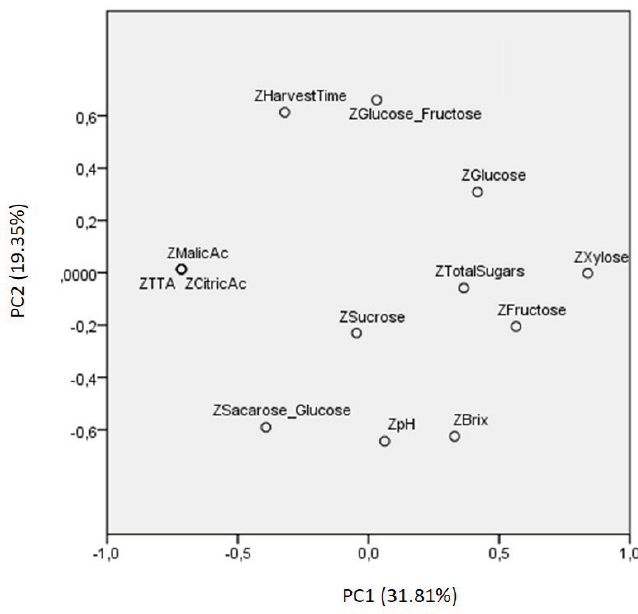
Fig. 2: Principal component analysis (PCA) of agronomical and biochemical traits of local accessions. PC 1 (nutritional content) and PC 2 (organ - oleptic qualities that influence consumer taste and the transformation processes for elaborating transformed